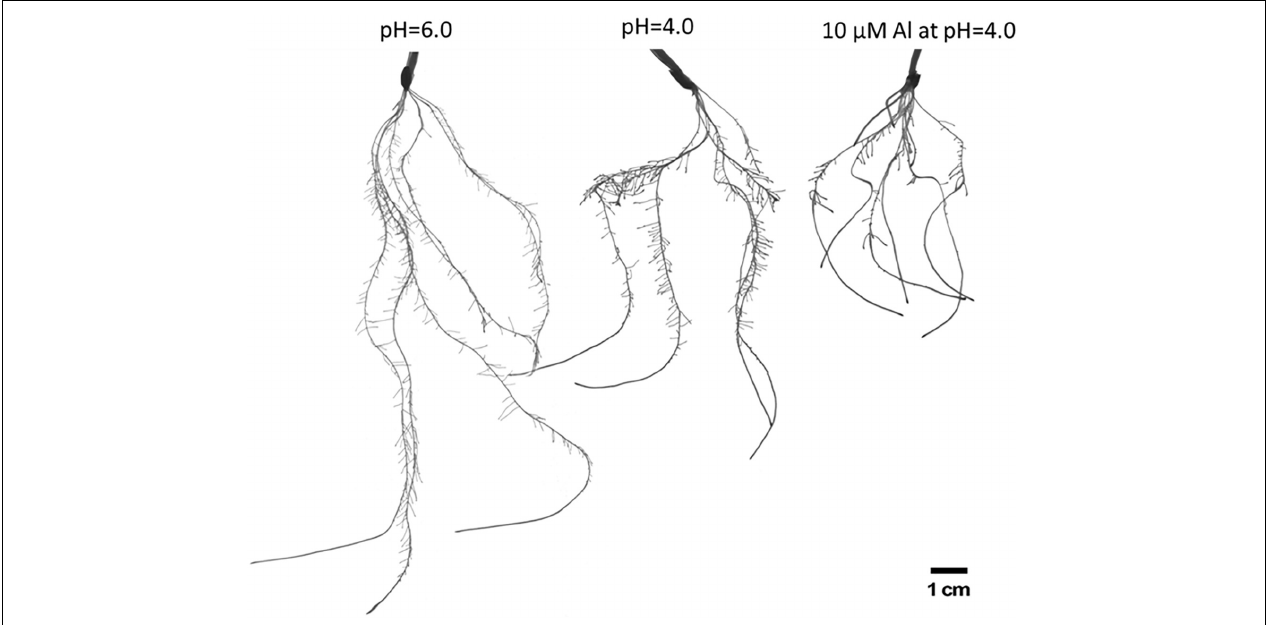
FIGURE 2 | The comparison of root systems of barley cv. ‘Sebastian’ after 7 days growth in hydroponics in Magnavaca medium at pH = 6.0, pH = 4.0, and with 10 µ M of bioavailable Al 3 + ions at pH =